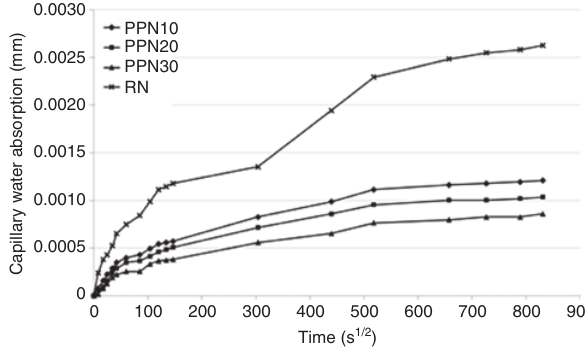
Figure 13 Capillary water absorption of polyvinyl chloride powder containing normal strength concretes.